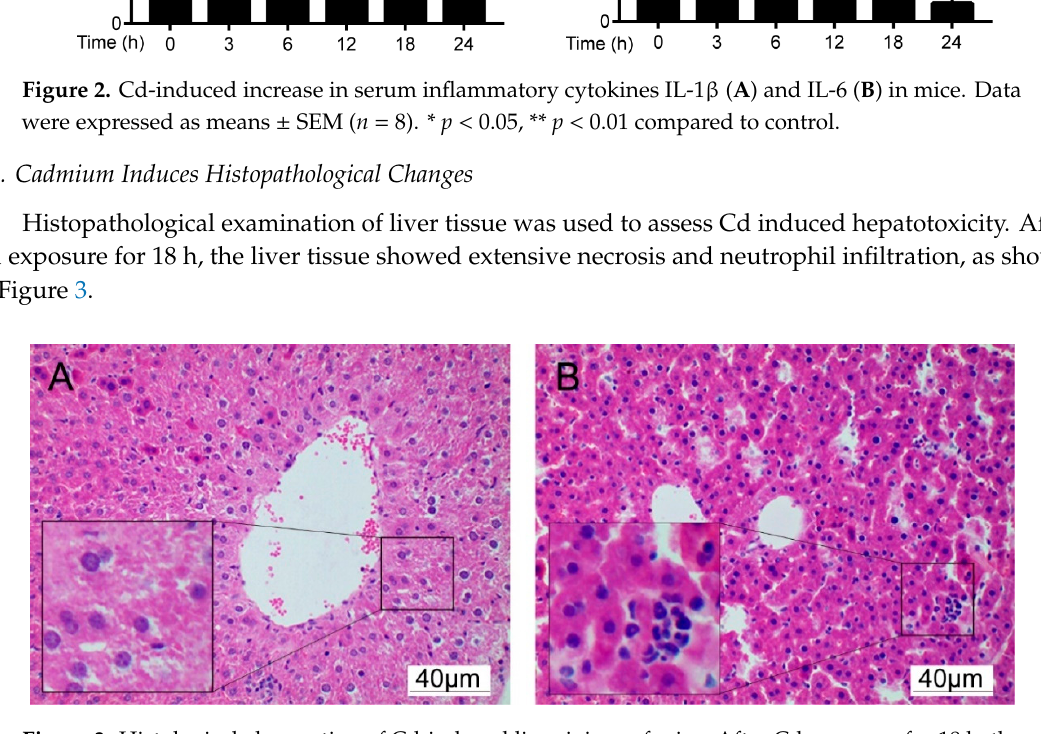
Figure 3. Histological observation of Cd-induced liver injury of mice. After Cd exposure for 18 h, the liver was collected for section and processing for H&E staining ( n = 3). ( A ) Control, ( B ) Cd (4 mg / kg) 18 h (magnification ×